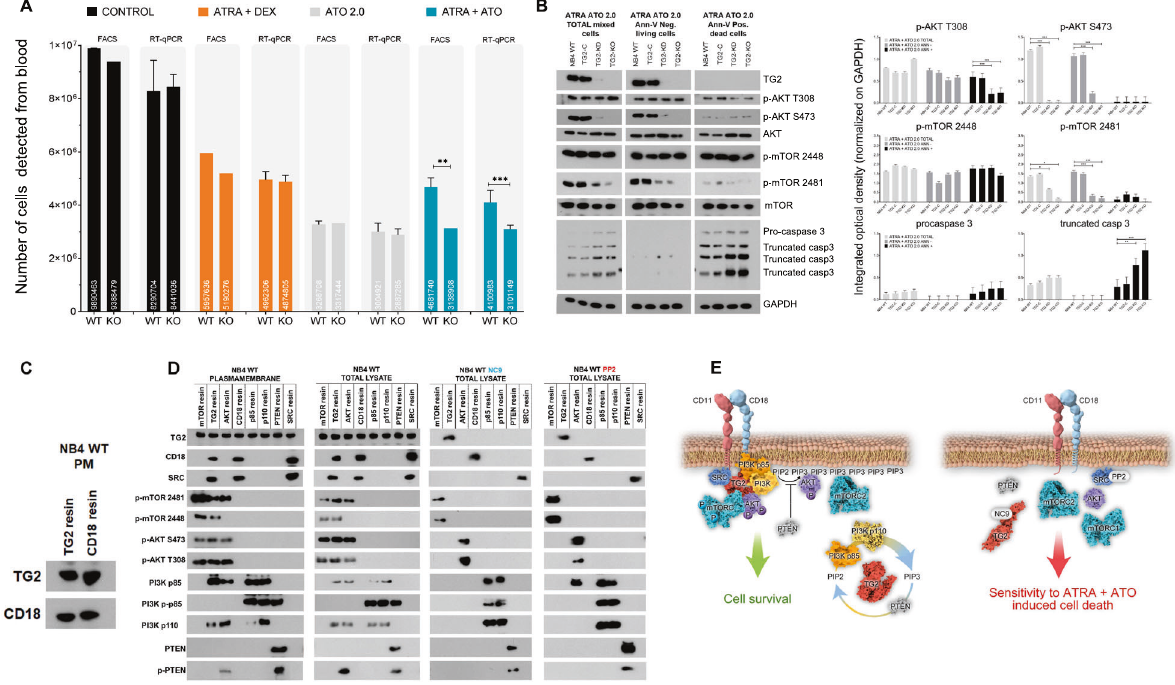
intraperitoneal injection of ATRA 1.0 mg/kg + DEX at 50 µg, ATO at 0.75 mg/kg, or ATRA + ATO every two days. At day 14, blood samples were collected from the heart and analysed for total numbers of NB4 WT and TG2-KO cells by FACS and human-ALU-based RT-qPCR analyses. Graphs show the mean ± SD values after 14 days ( n = 4). Statistical analysis was conducted by two-way ANOVA (Bonferroni post hoc test; * p < 0.05, ** p < 0.01 and *** p < 0.001, **** p < 0.0001). B Representative western blot showing expression of TG2, p-AKT (S473, T308), AKT, p-mTOR (2481, 2448), mTOR, pro-caspase3/truncated forms, and GAPDH proteins in the total cell lysate or in a cell population sorted by Annexin-V labelling ( n = 7). C Representative IP-western blot showing plasma membrane CD18 and TG2 protein expression levels